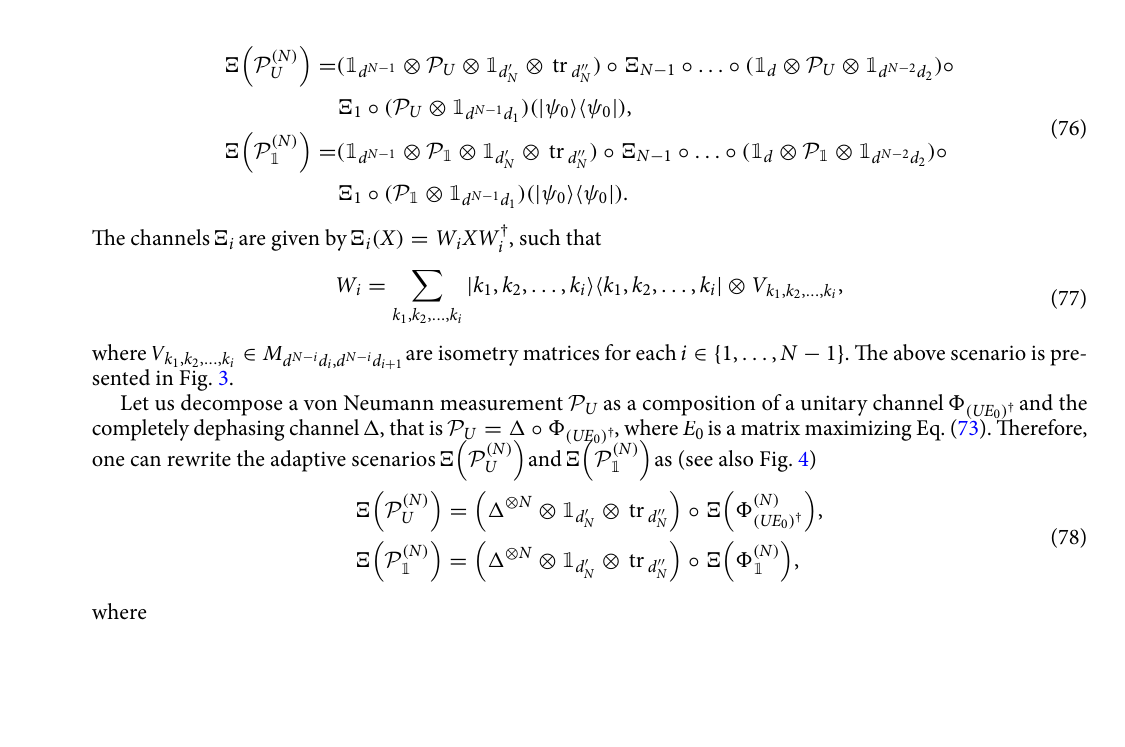
Figure 4. An equivalent description of Eq. (76), formalized as Eq. (78). The scenario �( of unitary channel (cid:31) , where �